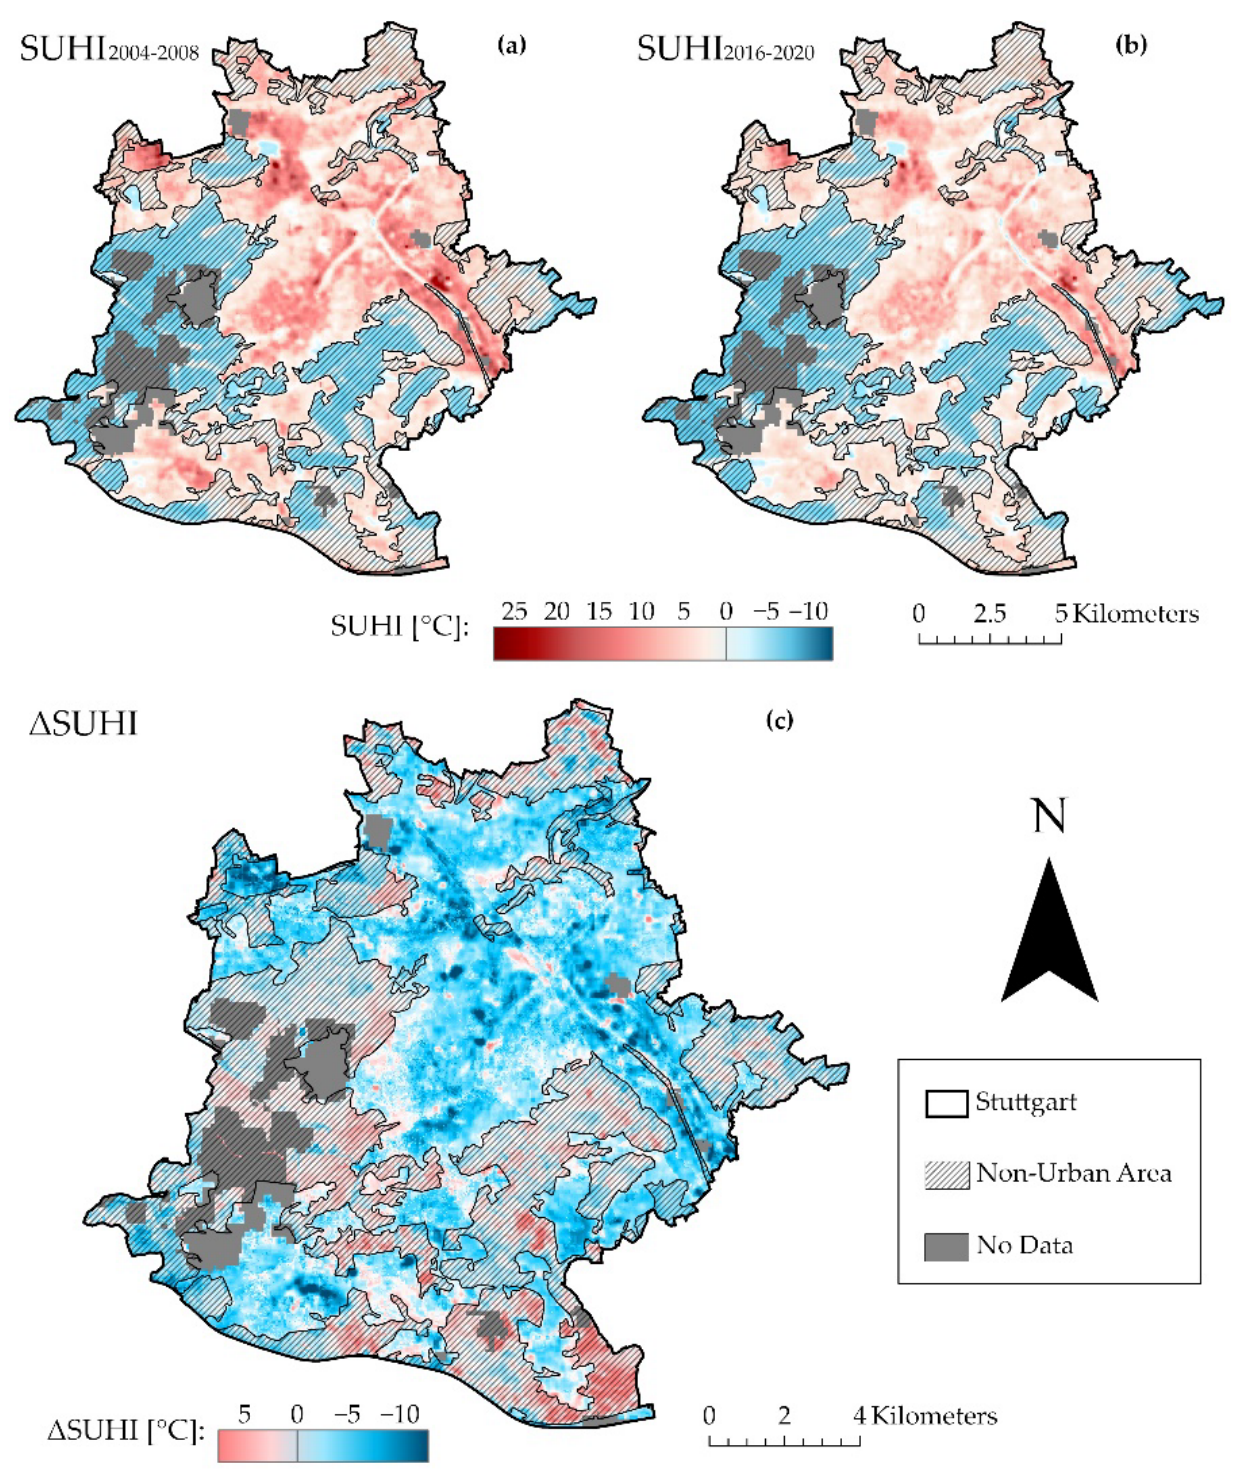
Figure 1. The surface urban heat island (SUHI) in Stuttgart in ( a ) 2004–2008 and ( b ) 2016–2020, and ( c ) the difference in SUHI ( ∆ SUHI) between both time periods. Non-urban areas are hatched, and areas with no data are depicted in grey. Note that colourmap limits in ( c ) differ from ( a , b ).